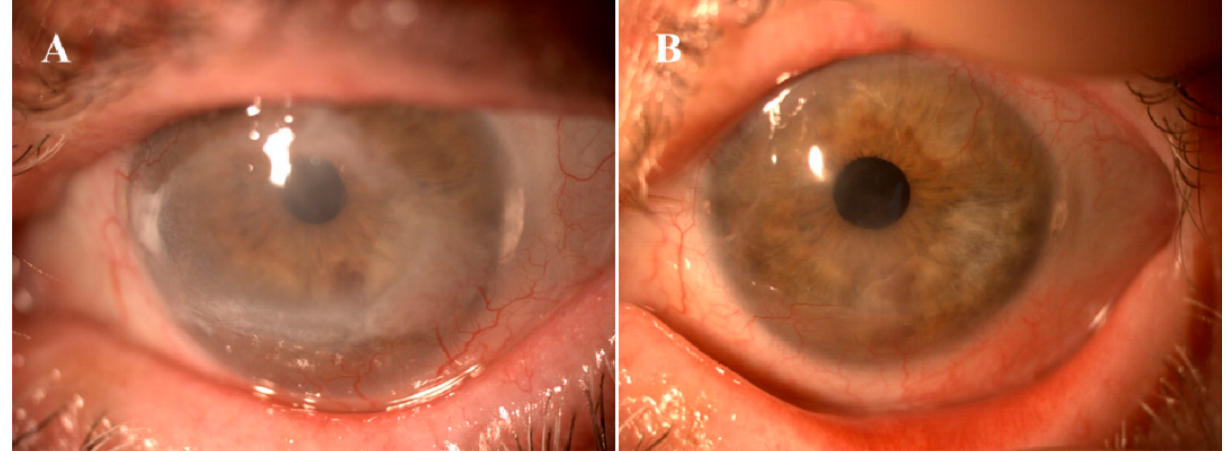
Figure 2. 64-year-old female with chronic epithelial defect due to local chemotherapy for ocular surface neoplasia. Before ( A ) and 12 months after mesenchymal stem cell transplantation ( B ).